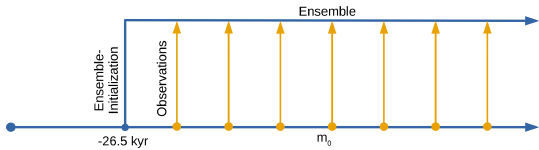
Figure 3. Set-up of the identical twin experiment. The ensemble of particles is initialised from the model state of the target run m 0 at t 0 = − 26 . 5ka. During the assimilation steps, observations of RSL rates, obtained from the target run, are assimilated into the ensem- ble. This is done every